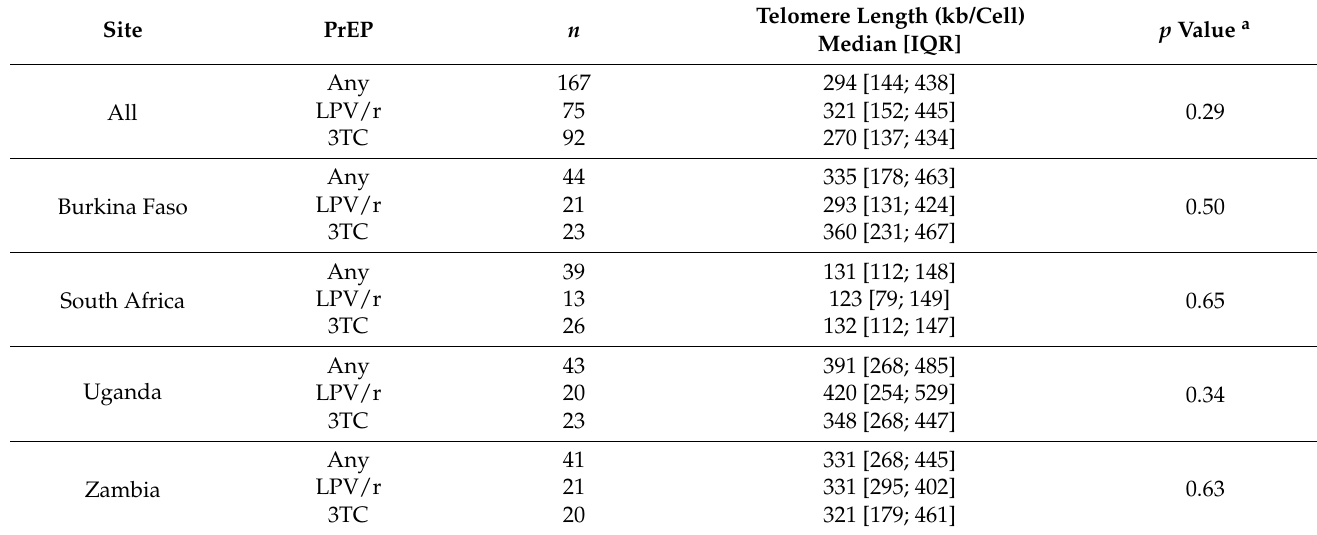
Table 3. Children’ telomere length at day-7.